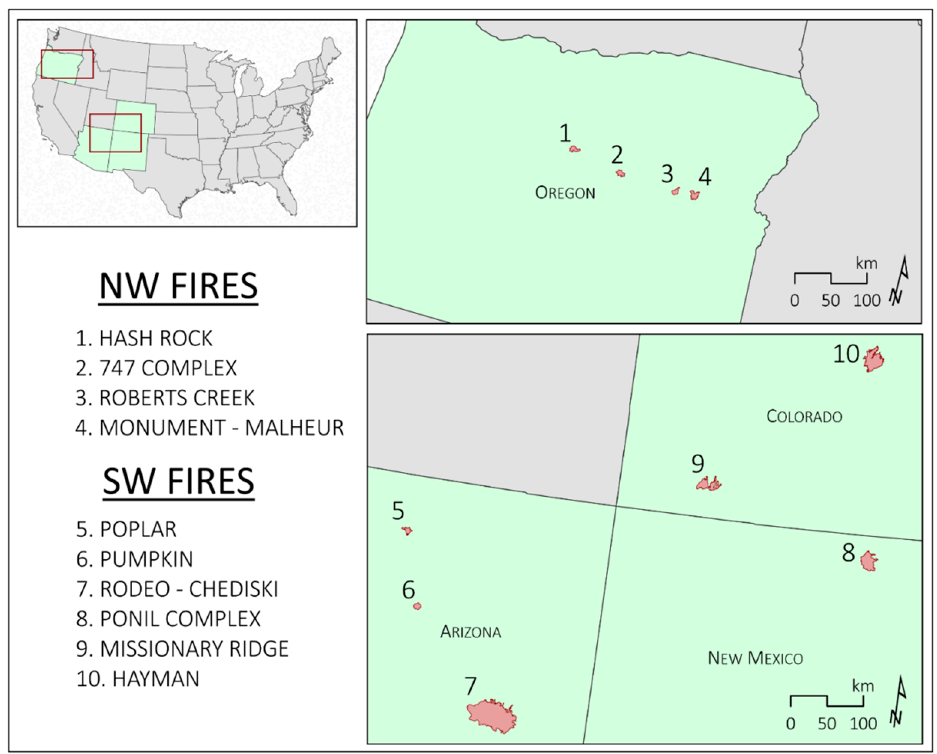
Figure 1. Study fires (indicated by red fire perimeters) across the northwestern and southwestern study regions.